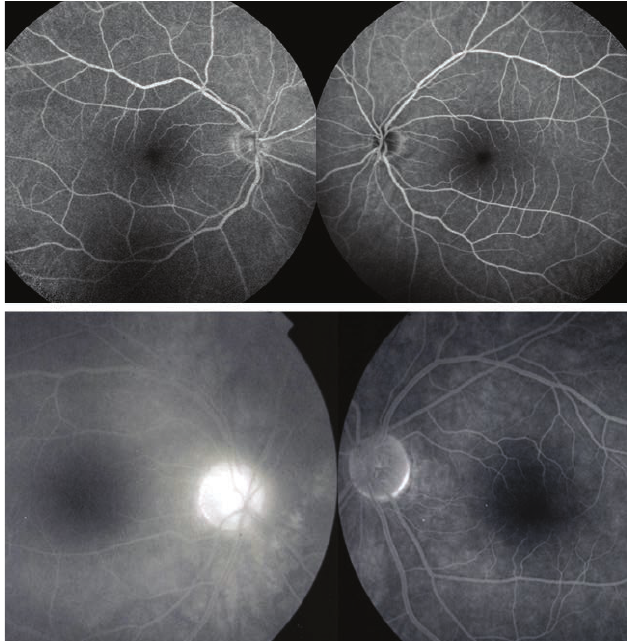
Figure 3. Absence of disc hyperfluorescence in the right affected eye on FA in the presented case (top angiographic frames). In comparison, bottom two frames show the typical disc hyperfluorescence seen in Fuchs’ uveitis.